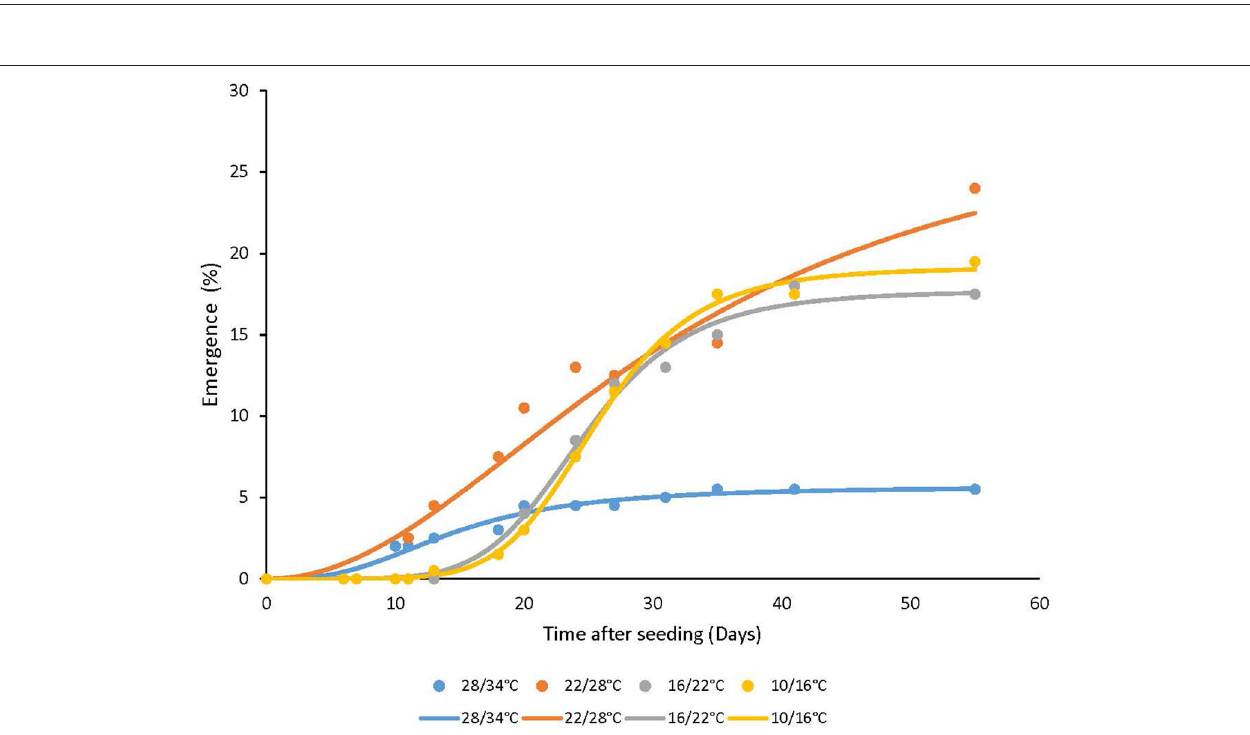
FIGURE 1 | A. confertiflora emergence rate at four temperature regimes, 55 DAS. Columns within each temperature regime topped by different letters are significantly different according to Tukey-Kramer HSD, p = 0.05.